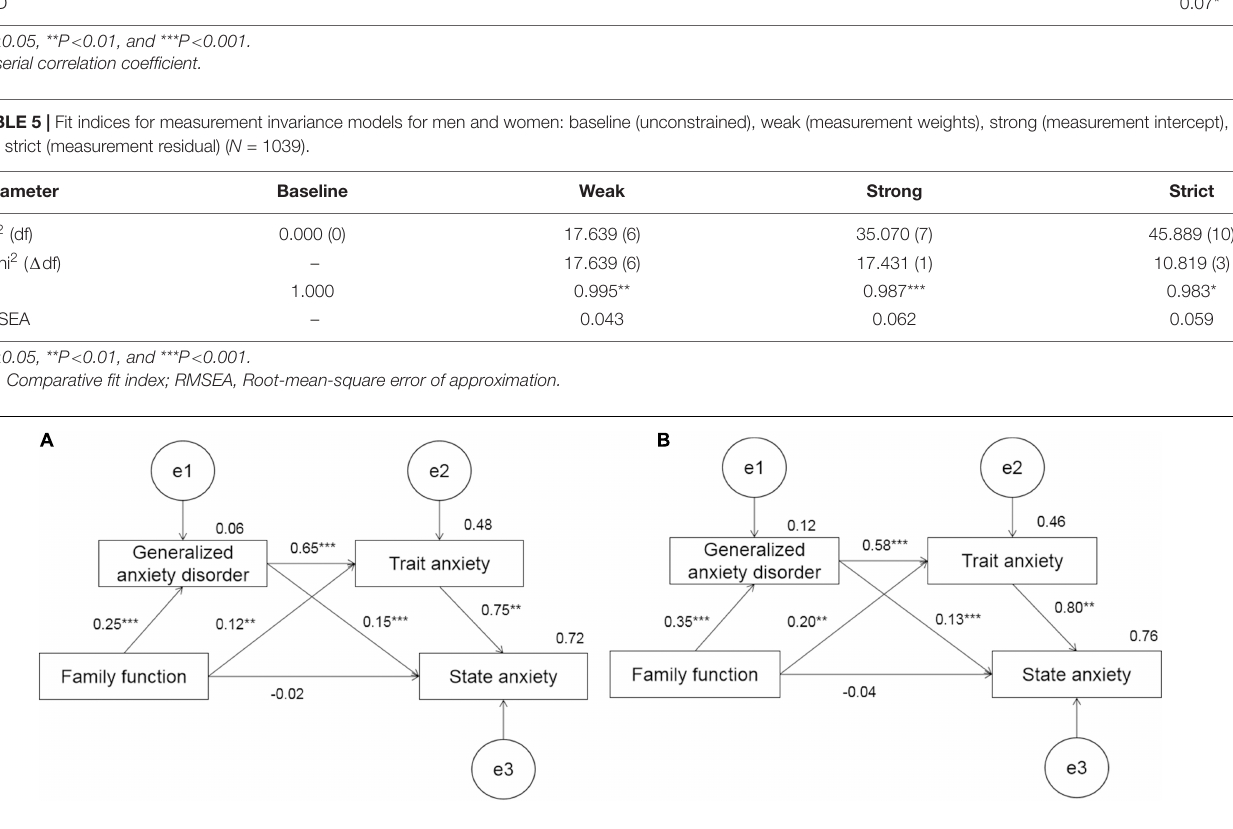
FIGURE 1 | Standard path analysis of family function, GAD, state, and trait anxiety for females and males. (A) Female and (B) male are included. ** P < 0.01 and *** P < 0.001. TABLE 6 | The results of estimation about standard parameters in path coefficients among family function, GAD, state anxiety, and trait anxiety for females and males.